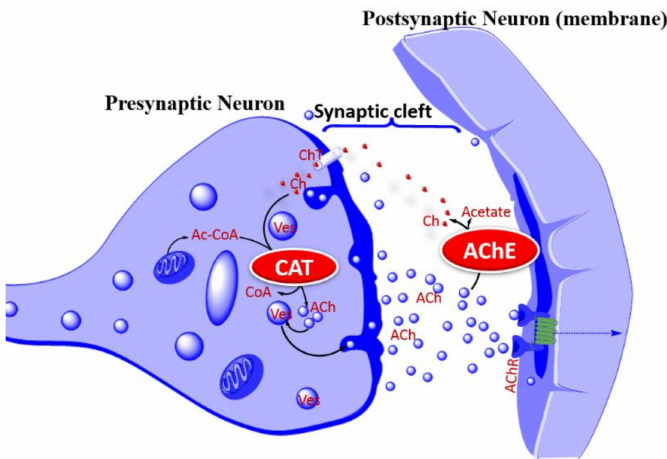
Figure 3. Acetylcholine release process and the cholinergic hypothesis of AD. The cholinergic hypothesis of AD is based on the putative role of cholinergic neurons in learning, memory, and cognition. Deletion of cholinergic neurons in AD is evident from the low levels of CAT, AChR, or choline in key brain regions associated with cognition. As a therapeutic proof of concept, augmenting Ach release, increasing AChR activity, or increasing the lifespan of ACh can overcome the cholinergic neuron deficiency in AD pathology. In the latter case, inhibition of AChE is the common therapeutic approach for increasing the activity of surviving cholinergic neurons. Abbreviation: ACh, acetylcholine; Ac-CoA, acetyl-CoA; AChE, acetylcholinesterase; AChR, acetylcholine receptor; Ch, Choline; CAT, choline acetyl transferase; CoA, coenzyme A; ChT, Choline transporter (carrier); Ves,